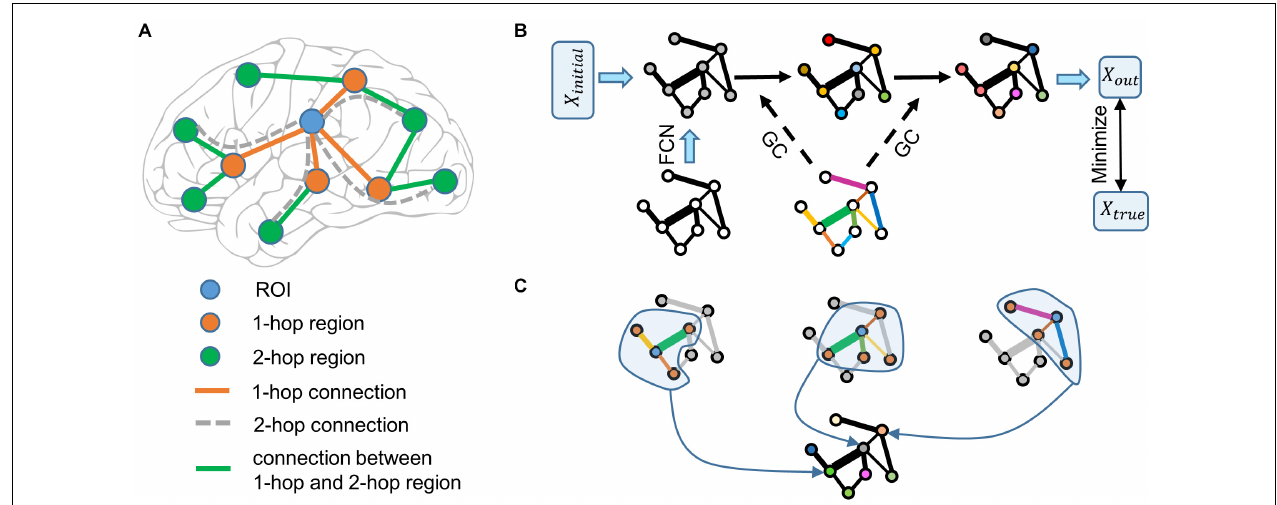
FIGURE 1 | Schematic illustration of the graph neural network. (A) Functional information of the ROI (blue node) is transferred from the 1-hop regions (orange nodes) via the 1-hop connections (orange edges), and the functional information of the 1-hop regions is transferred from the 2-hop regions (green nodes) via 1-hop regions’ connections (green edges). The 2-hop regions indirectly connect to the ROI via 1-hop regions through the 2-hop connections (only four examples of gray dashed edges are shown). The dashed line indicates that the connection does not really exist. (B) Node color represents the functional information of brain regions. Edge width represents the strength of functional connectivity pathways. Edge color represents the coefficient of graph convolution (GC), i.e., the extent to which each connection participates in the functional information propagation. Initial functional information (a vector of ones) transfers within the functional connectivity network (FCN) through the graph convolution network. Coefficients of GC are trained by minimizing the error between the predicted output and true functional activation. (C) Three examples of graph convolution computation are shown. Central nodes (blue) integrate functional information from 1-hop regions (orange) to update its information. Graph convolution coefficients (edge color) indicate the extent to which each connection (edge width) participates in the functional information propagation.